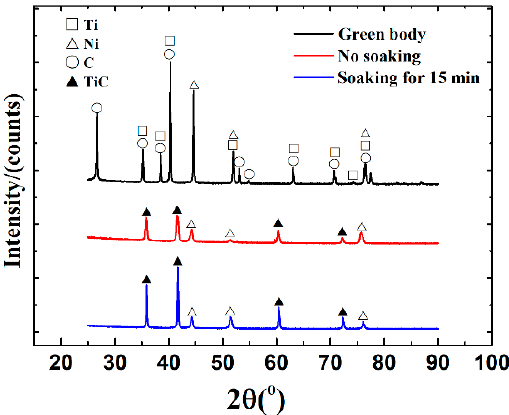
Figure 6. XRD patterns of the original green body, and the sintered green bodies with and without soaking for 15 min at 1200 °C in a vacuum induction melting furnace.